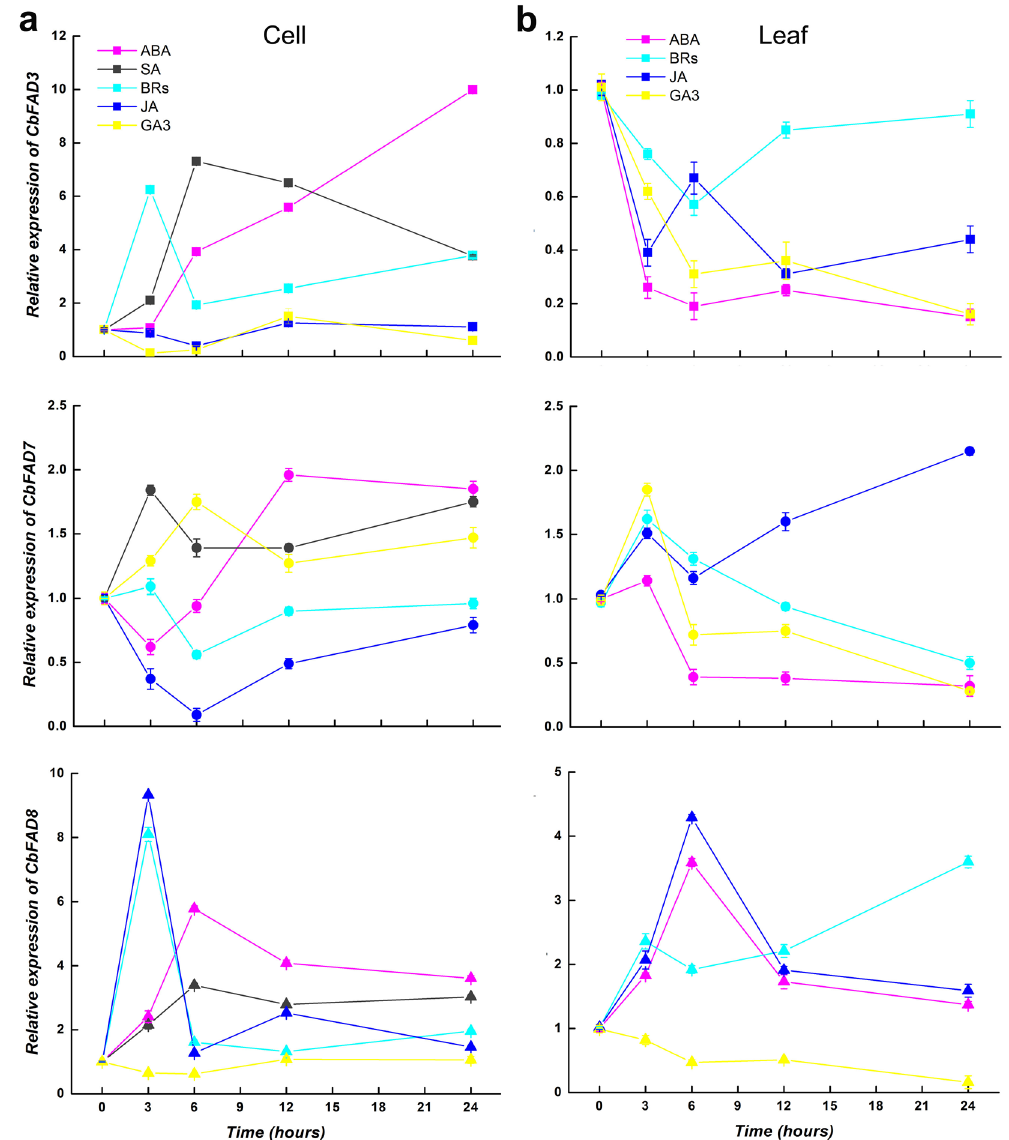
Figure 4. Hormone-responsive expressions of ω-3 CbFAD genes in C. bungeana. ( a ) Expression patterns of CbFAD3 , CbFAD7 and CbFAD8 in suspension-cultured cells. ( b ) Expression patterns of CbFAD3 , CbFAD7 and CbFAD8 in the leaves from regenerated plants. Data were presented as relative expression ratios being compared with the expression levels of corresponding genes before treatment (0 h), which were set at a value of 1. Each value represents the mean ± SE of three replicates. The relative expressions of CbFAD3 , CbFAD7 and CbFAD8 are indicated by square, circle and triangle,